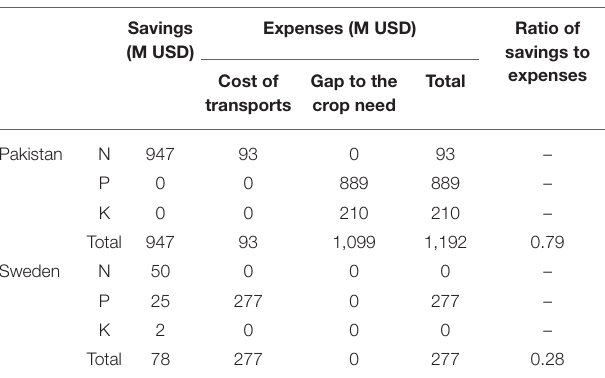
TABLE 4 | Savings on synthetic fertilizers (millions of US dollars) associated with decimal resolution optimized recycling of excreta vs. transport costs incurred and additional costs for synthetic fertilizers to meet crop nutrient need in Pakistan and